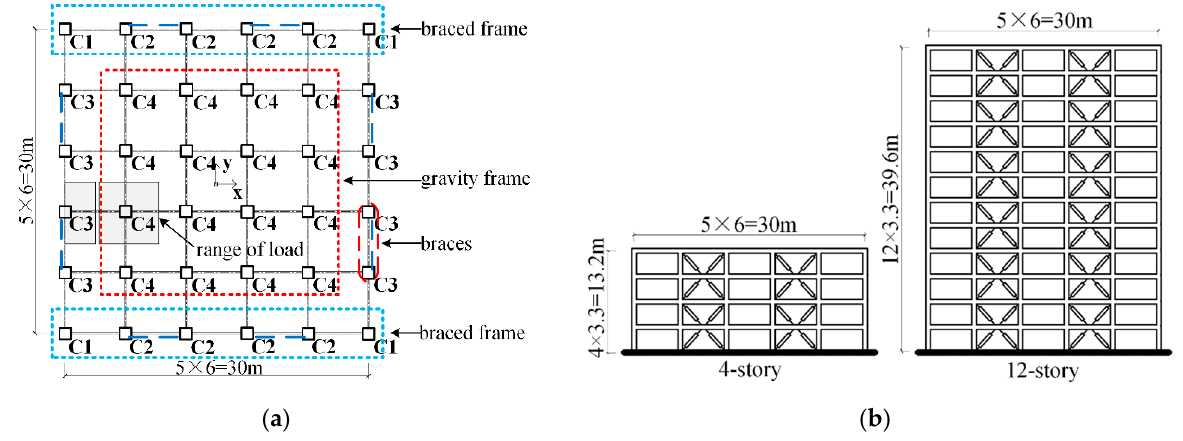
Figure 9. Structure layout: ( a ) structural plane arrangement and ( b ) vertical structural arrangement. To reduce the influence of the brace tension on the adjacent columns, all the joints of the peripheral frame were set as rigid connections. As for the gravity frame, the beam- column joints and the bottom of the first-floor frame columns were hinged. The articulated beam-column joints were connected by bracket bolt pins, and the rigid beam-column joints were connected by bolts, as shown in Figure 10. The failure mode of bolted beam-column joints was the same as that of cast-in-place beam-column joints [42]; thus, the PCF-BRB structure modeling method was the same as that of the cast-in-place structure. This study did not pay attention to the influence of the size of gusset plates, which were designed as unified rectangular steel plates 600 mm in length and 300 mm in width. Frame beams and columns were auto-meshed at intermediate joints and intersections with other frames and area edges. Generally, there was a beam element in each span, but if the BRB gusset plate was in the midspan, there were two beam elements. The hinges’ distance from ends was set as half the height of frame beams and columns. The relative length of the frame element at the hinges was 0.02, which was auto-set in ETABS. In frame beam sections, the core concrete fiber size was 100 mm in width and 40 mm in height. In frame